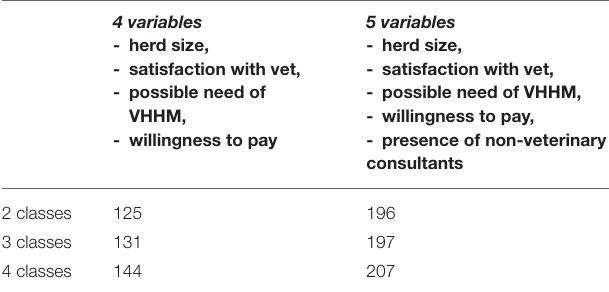
TABLE 10 | No VHHM: Latent class analysis. TABLE 11 | No VHHM: LCA-Model selection based on